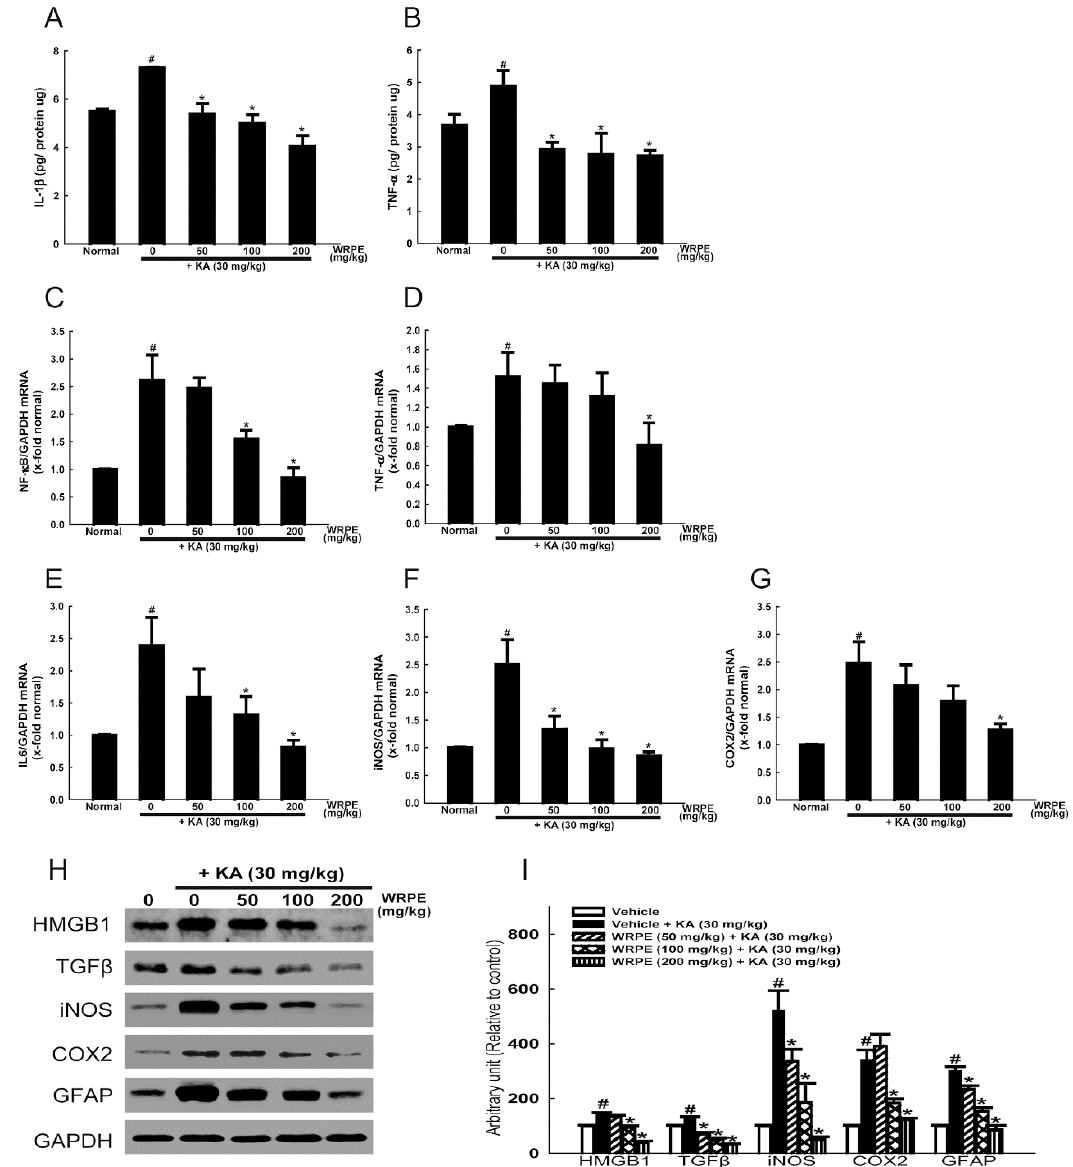
Figure 5. Anti-inflammatory activity of white rose petal extract (WRPE) in kainic acid (KA)-challenged mice. ( A , B ) ELISA analysis of IL-1 β ( A ) and TNF- α ( B ) in the brain tissue. ( C – G ) Real-time PCR analysis of mRNA of NF- κ B ( C ), TNF- α ( D ), IL-6 ( E ), iNOS ( F ), and COX2 ( G ) normalized to GAPDH. ( H , I ) Western blot analysis of proteins of HMGB1, TGF- β , iNOS, and COX2, showing representative bands ( H ) and band densities normalized to GAPDH ( I ). n = 5 per treatment group. # Significantly different from normal control ( p < 0.05). * Significantly different from vehicle control ( p < 0.05).